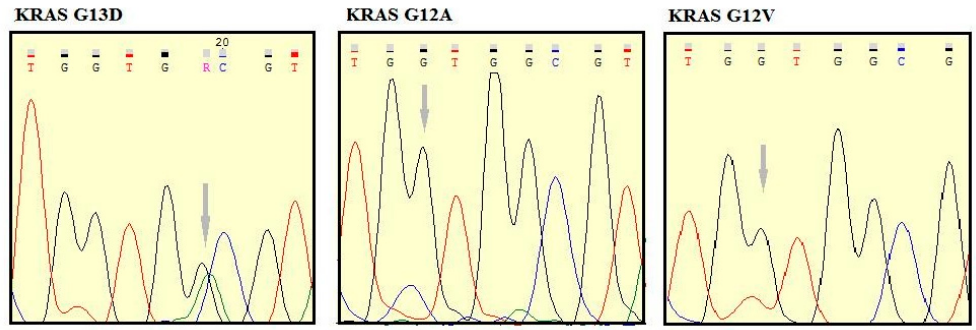
Figure 5. Sequencing by the standard method shows a mutant peak consistent with a G13D, G12A, and G12V mutation.